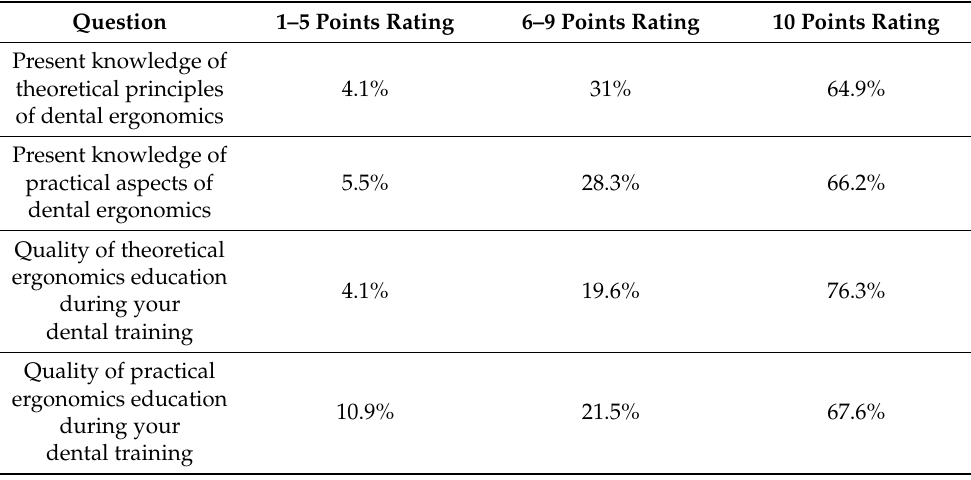
Table 2. Self-evaluation on theoretical and practical skills acquired during early dental ergonomics training and assessment of ergonomics education (second